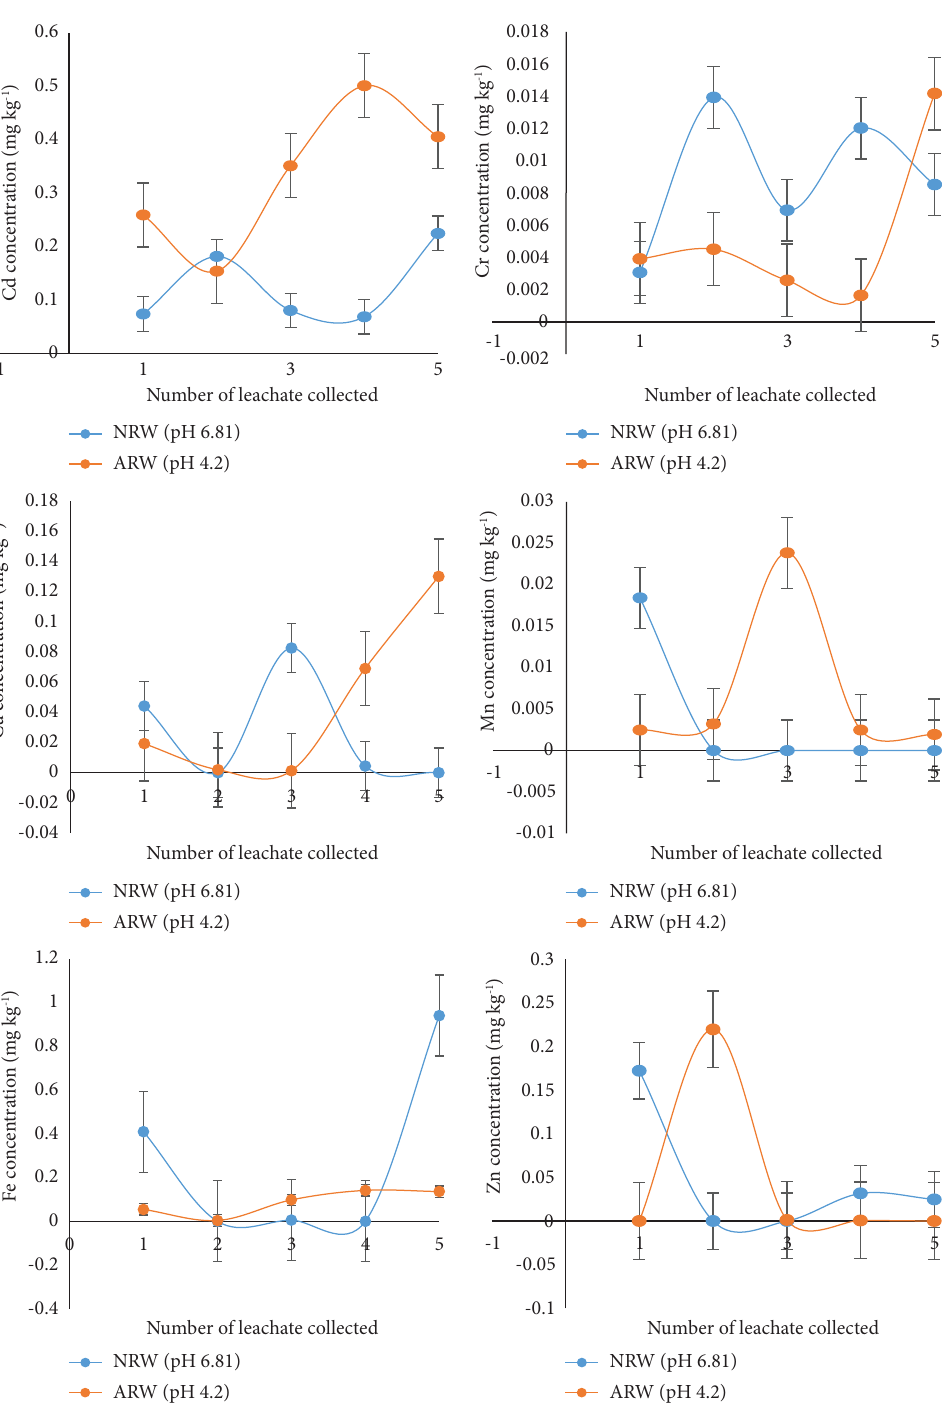
Figure 3: Efects of NRW and ARW on metal concentrations in leachate from soil